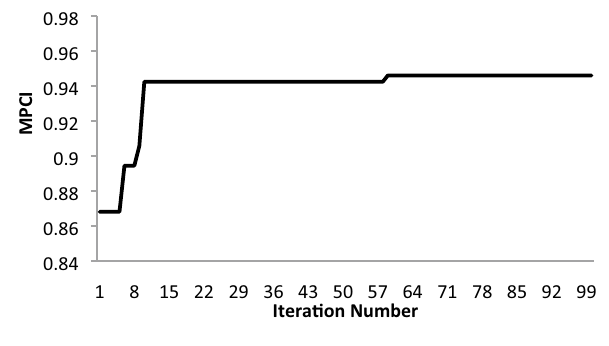
Fig. 9 The convergence curve